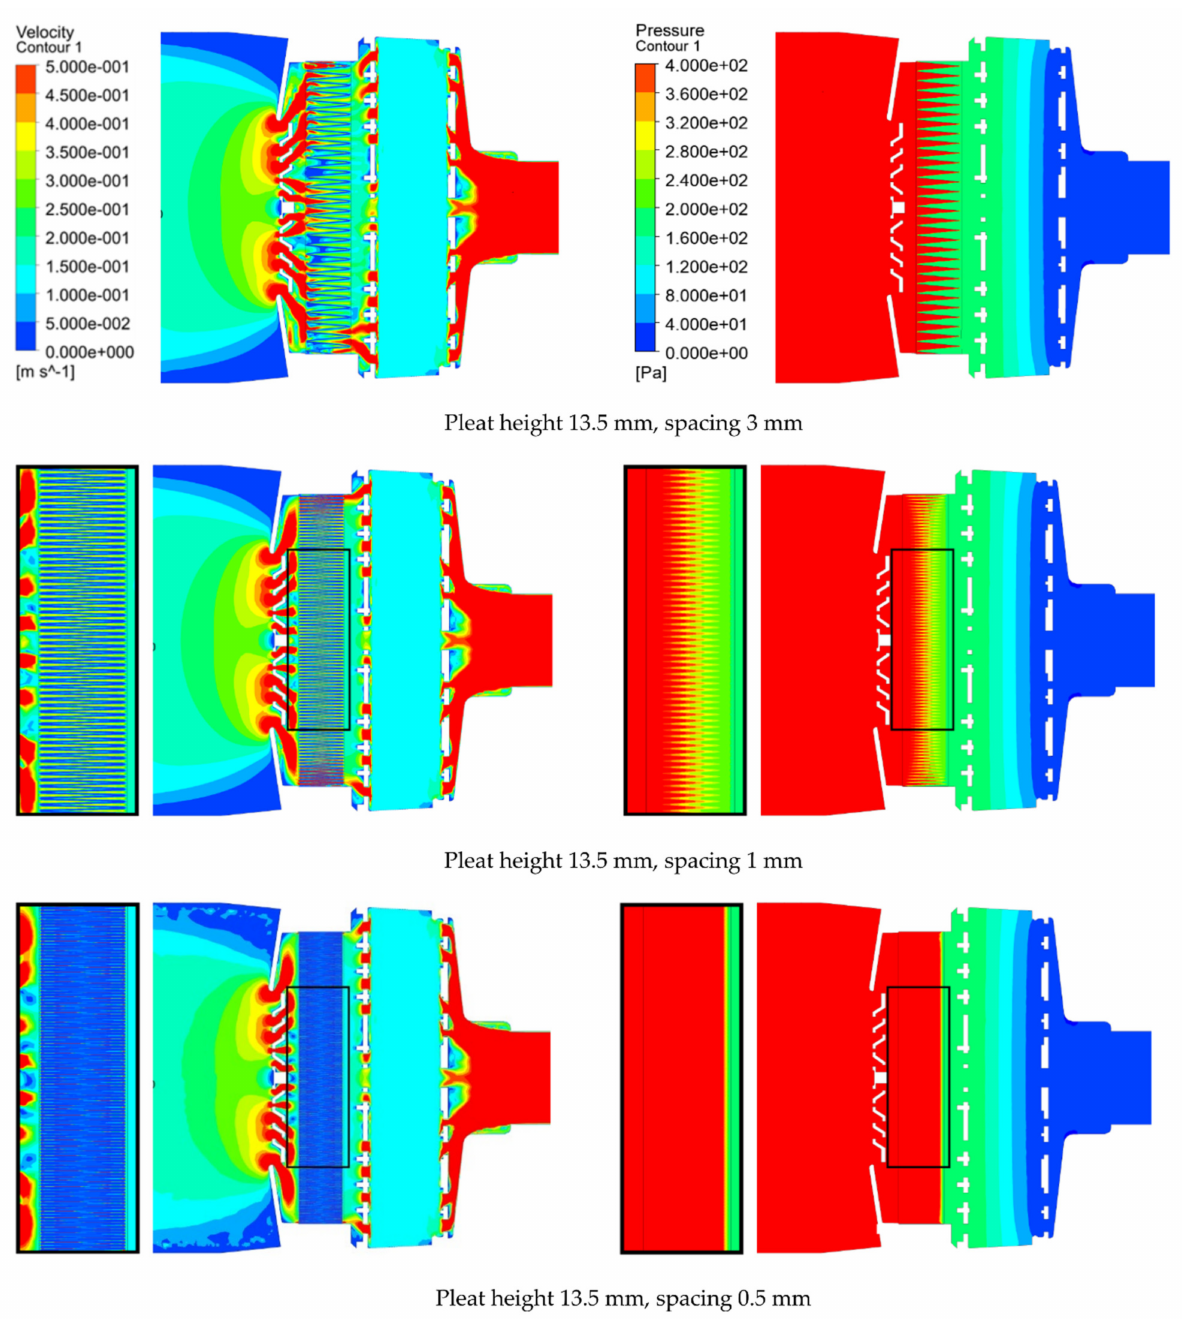
Figure 18. Velocity and pressure distribution in longitudinal section for different spacing of pleats at flow rate 70